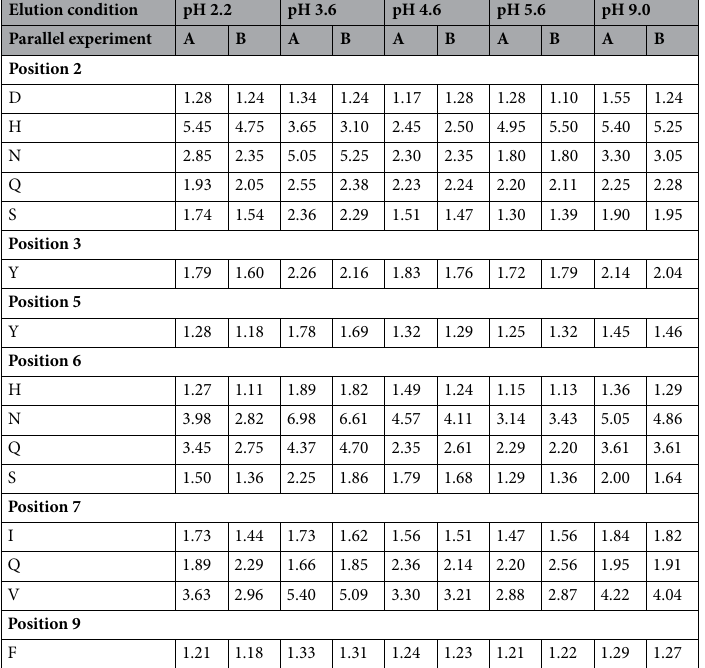
pH 3.6 and 9.0. Two branched amino acid residues valine and isoleucine together with glutamine were strongly enriched at position 7, while position 9 showed a strong preference for phenylalanine over tyrosine. It should be